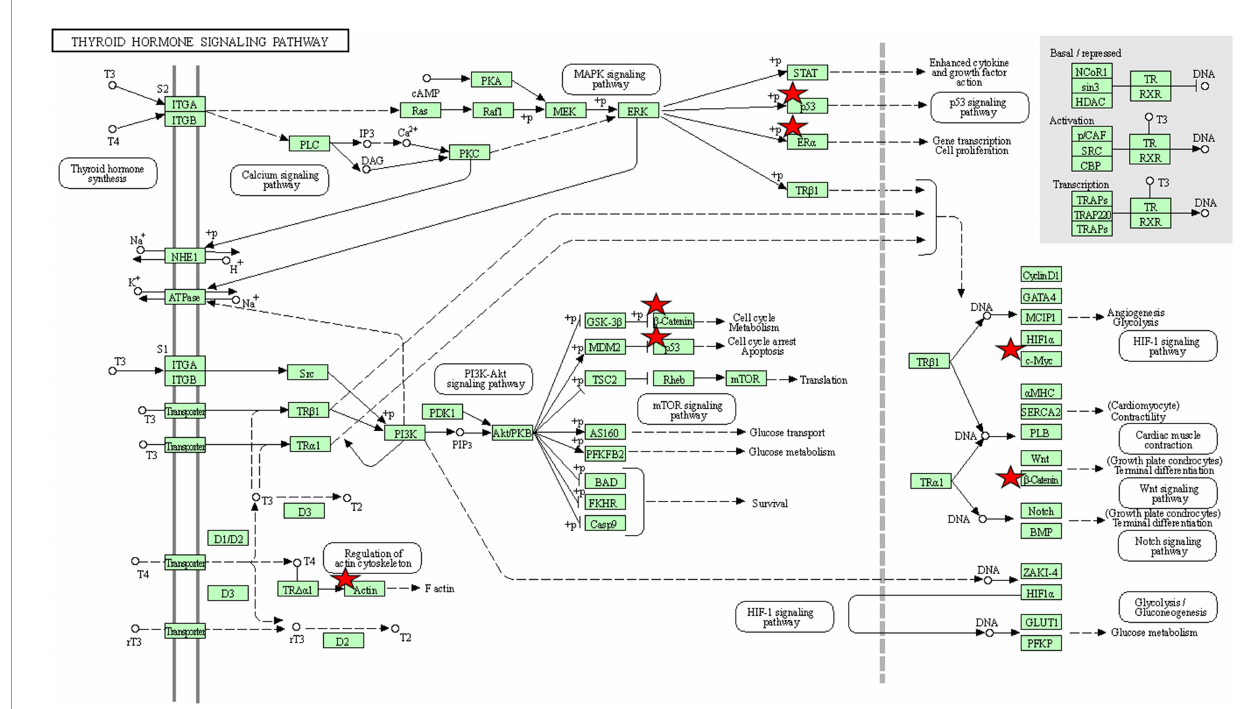
FIGURE 9 | The thyroid hormone signaling pathway enriched in KEGG. Objects with pentagrams are acting locus by mapped genes. KEGG, Kyoto encyclopedia of genes and